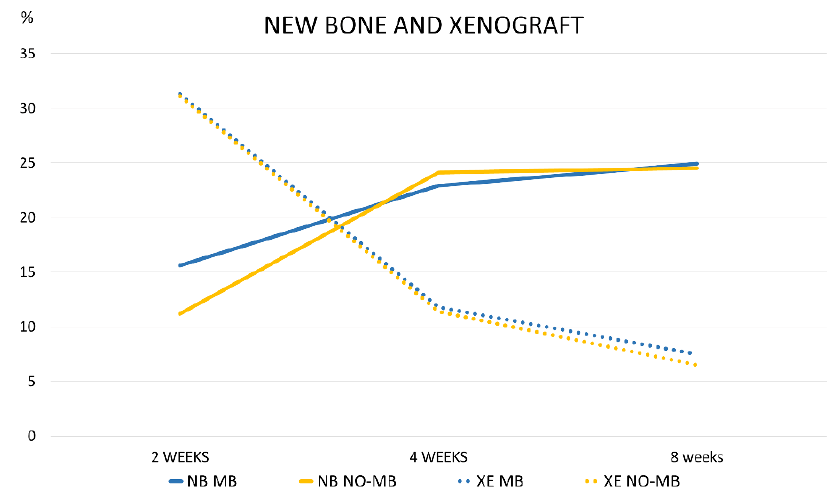
Figure 3. ( A ) Merged images from photomicrographs of sections of decalcified samples representing the healing after 2 weeks in the membrane group. Scarlet-acid fuchsine and toluidine blue. ( B ) Merged images from photomicrographs of sections of decalcified samples representing the healing after 2 weeks the in non-membrane group. Scarlet-acid fuchsine and toluidine blue.